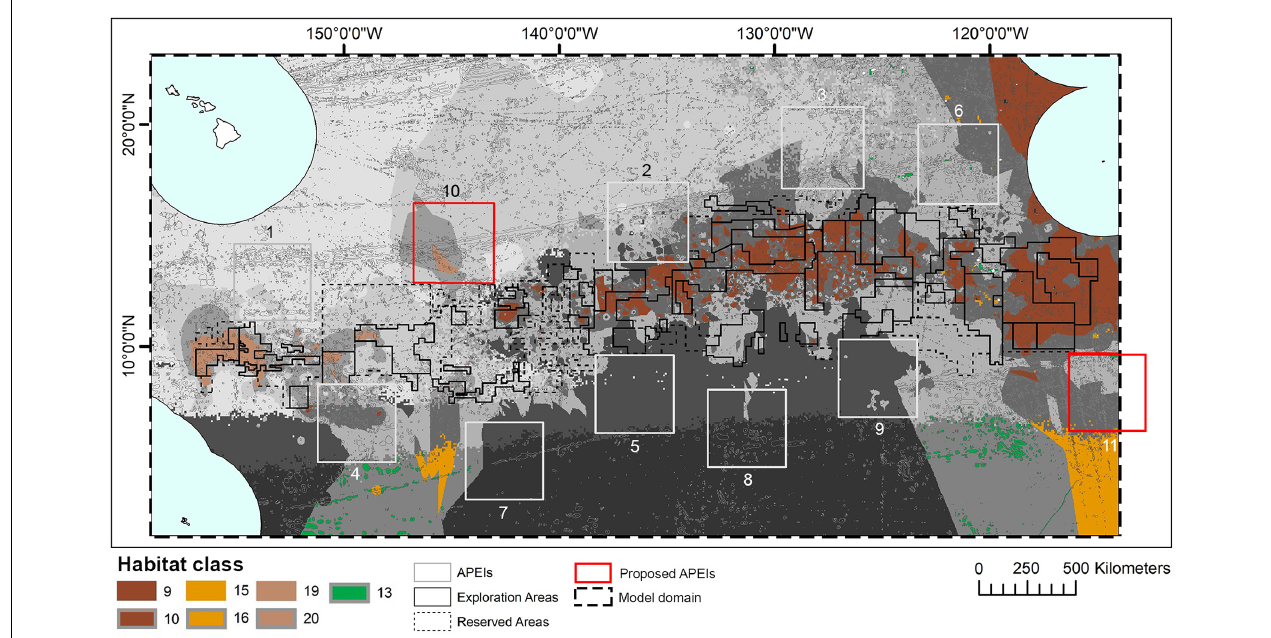
FIGURE 10 | Distribution of habitat classes 9, 10, 13, 15, 16, 19, and 20 (with 0%, or nearly 0%, representation in APEls) in relation to two new Areas of Particular Environmental Interest (APEls) proposed for inclusion in the current Clarion-Clipperton Fracture Zone APEI network: numbers 10, to the northwest, and 11, to the southeast. Other habitat classes shown in